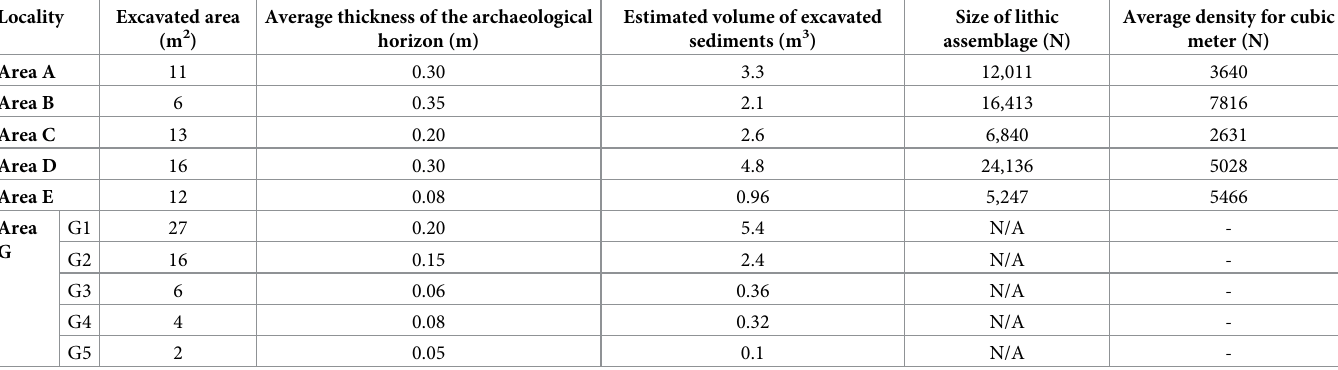
Table 3. Excavation details per locality. Lithic assemblages include all artifacts collected, including from sieving using 5 mm mesh. Locality Excavated area (m 2